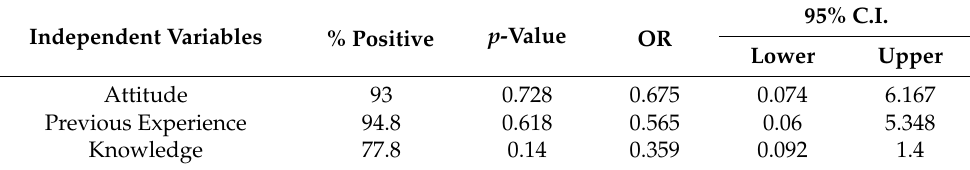
95% C.I. Lower Upper